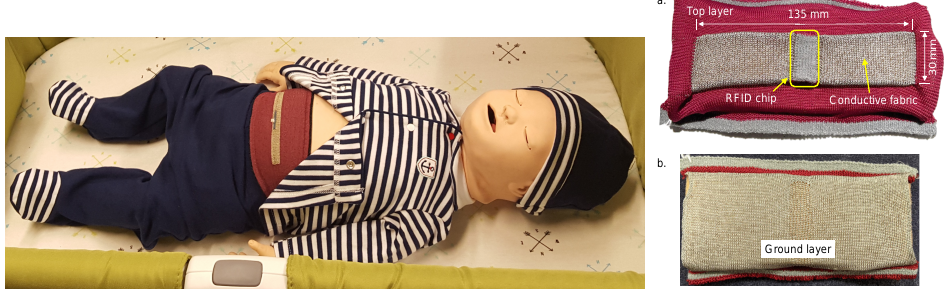
Figure 1. ( left ) A smart-fabric Bellyband and ( right ) Bellypatch can be integrated into wearable garments to enable wireless and passive biomedical monitoring in infants. ( a ) top and ( b ) bottom view of the